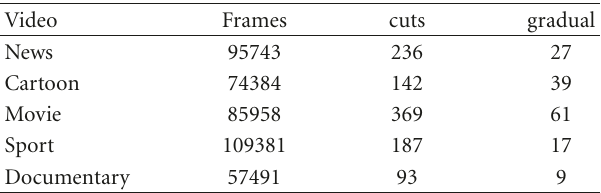
Table 1: Video set used in our